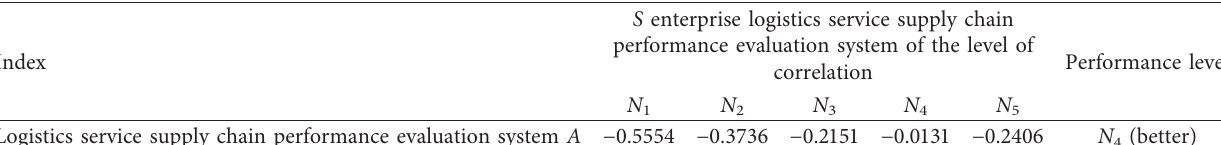
Table 7: The correlation degree of the five levels of the S enterprise logistics service supply chain performance evaluation